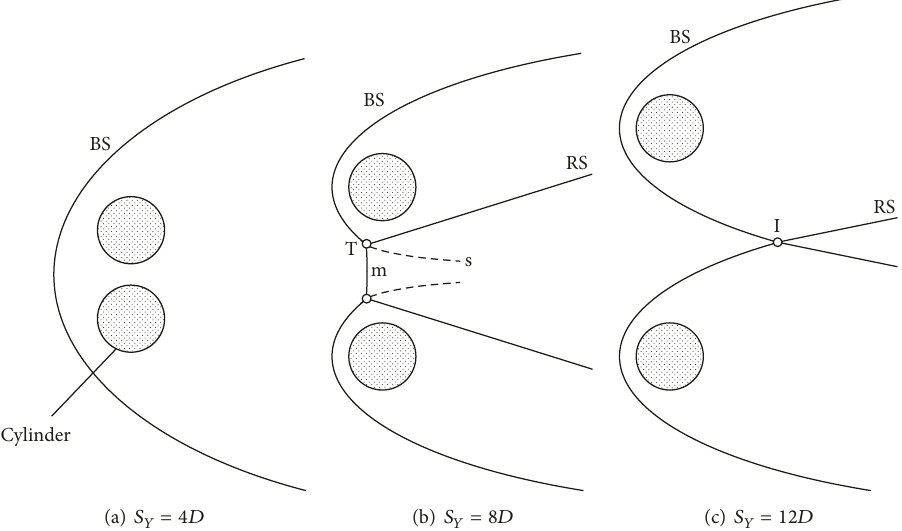
Figure 17: Three types of bow-shock interactions formed around cylinder arrays. BS, bow shock; RS, reflected shock; I, single interaction point; T, triple point; m, Mach stem; s, slip